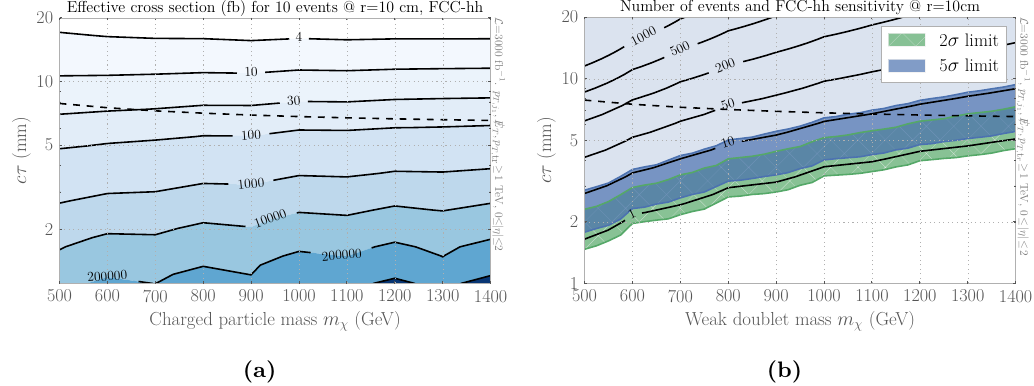
Figure 5. Results of conventional analysis: (a) E(cid:11)ective charged particle production cross section (de(cid:12)nition in text) required in order to obtain 10 disappearing charged track events in conventional analysis at r = 10 cm, and (b) number of disappearing charged tracks and sensitivity, normalized to the NLO pair-production cross section of a weak-doublet fermion with Dirac mass m (cid:31) and nominal decay length c(cid:28) . The plots are for a pp collider at p s = 100 TeV with 3000 fb (cid:0) 1 of integrated luminosity. The c(cid:28) corresponding to a pure-Higgsino state is shown as a dotted line. Superimposed onto the right panel (grey shaded region) is the FCC-hh sensitivity in this channel for a 50% background systematic, with the estimated uncertainties in the 5 (cid:27) (2 (cid:27) ) contours shaded in blue